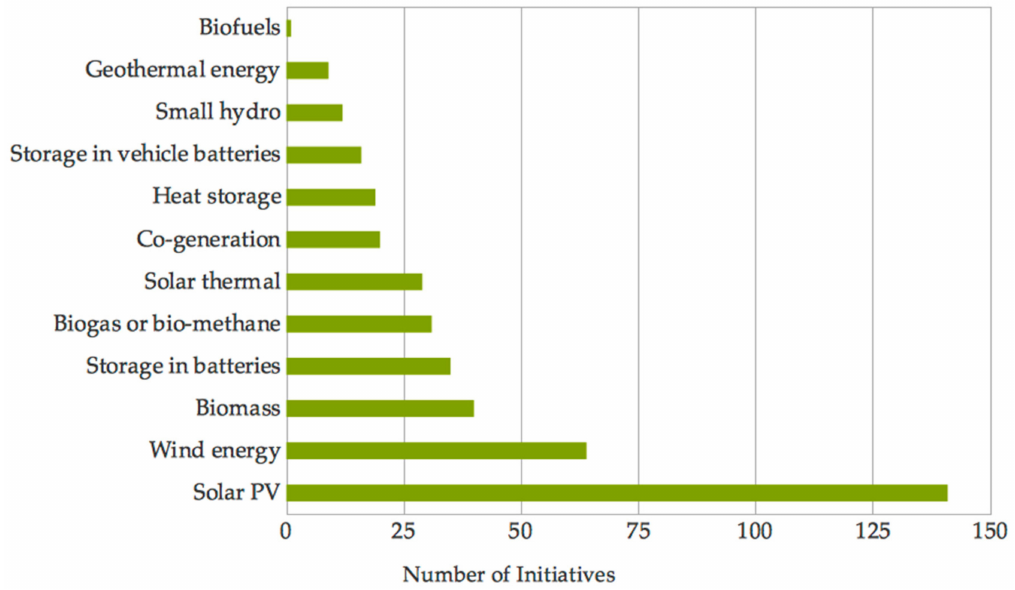
Figure 4. Renewable energy technologies